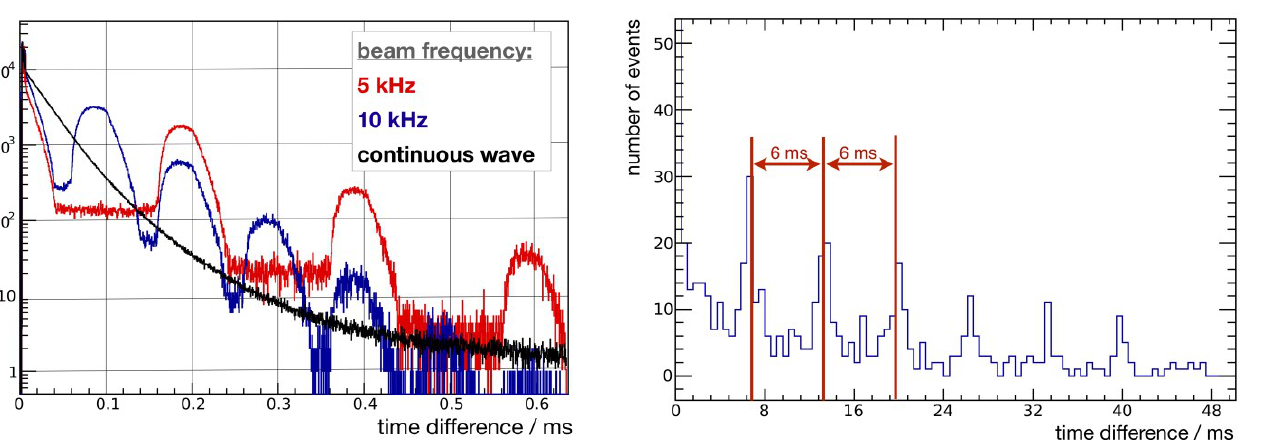
Figure 8. In the time-difference histogram, the timing structure of the initial beam is reproducible. The black curve belongs to the continuous wave beam and the red and blue curve to a pulsed beam with a pulse duration of 40 µs and a frequency of 5 kHz and 10 kHz, respectively. relative dose for the different detectors is equal to 1. For the